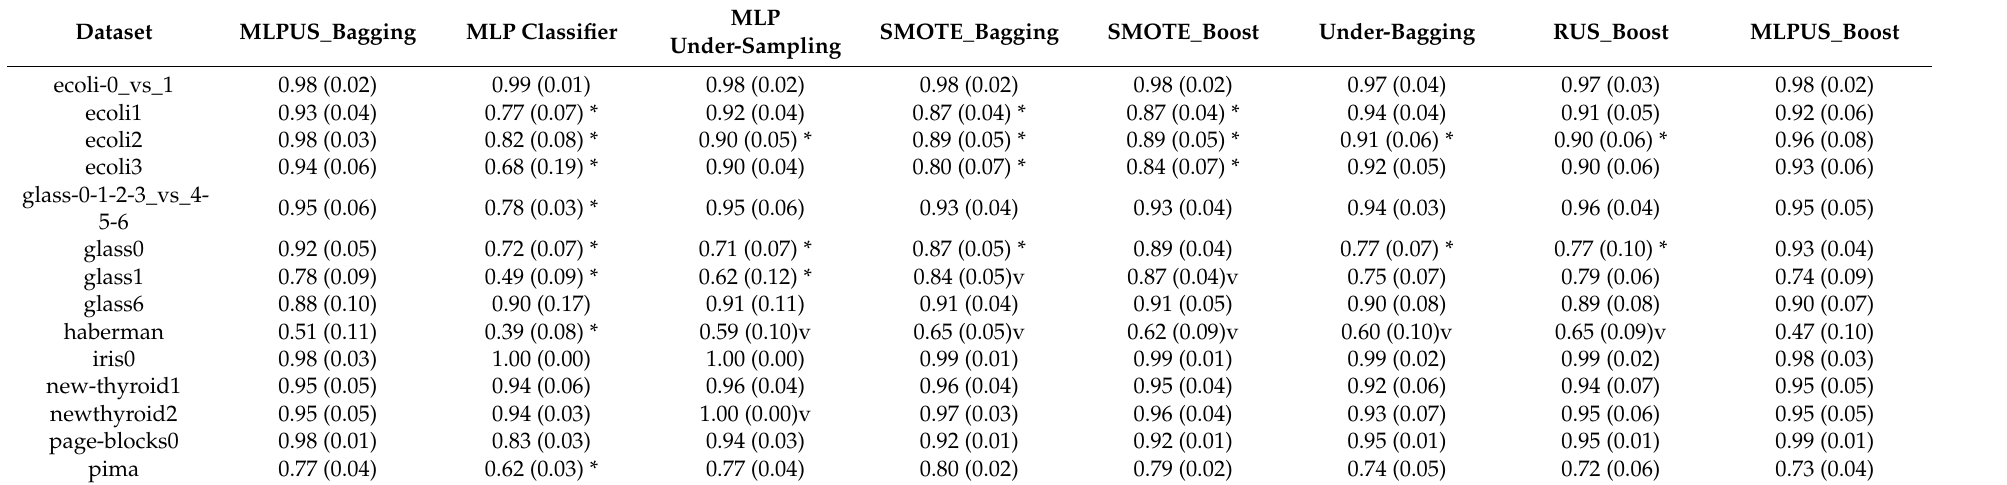
Table 5. F-Measure results of all methods for all